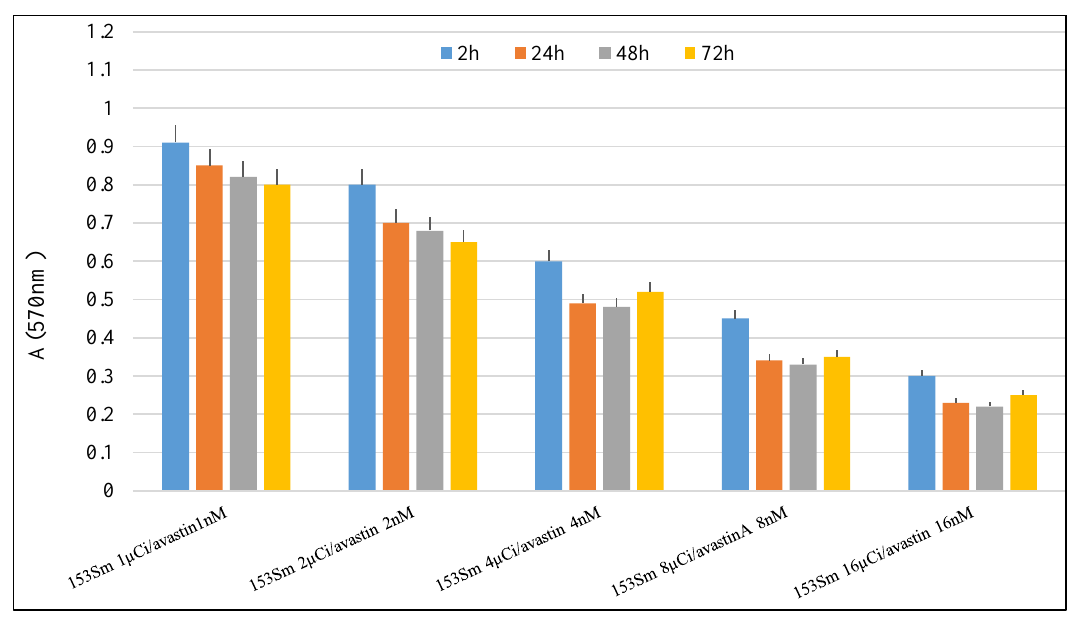
Figure 5C. Effect of 153 Sm-DOTA- avastin (radioimmonutherapy) on viability of SW480